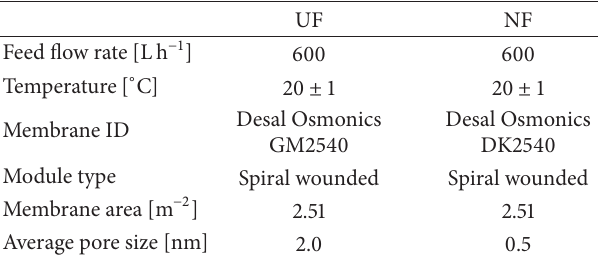
Table 1: Experimental setup for UF and NF, valid for all